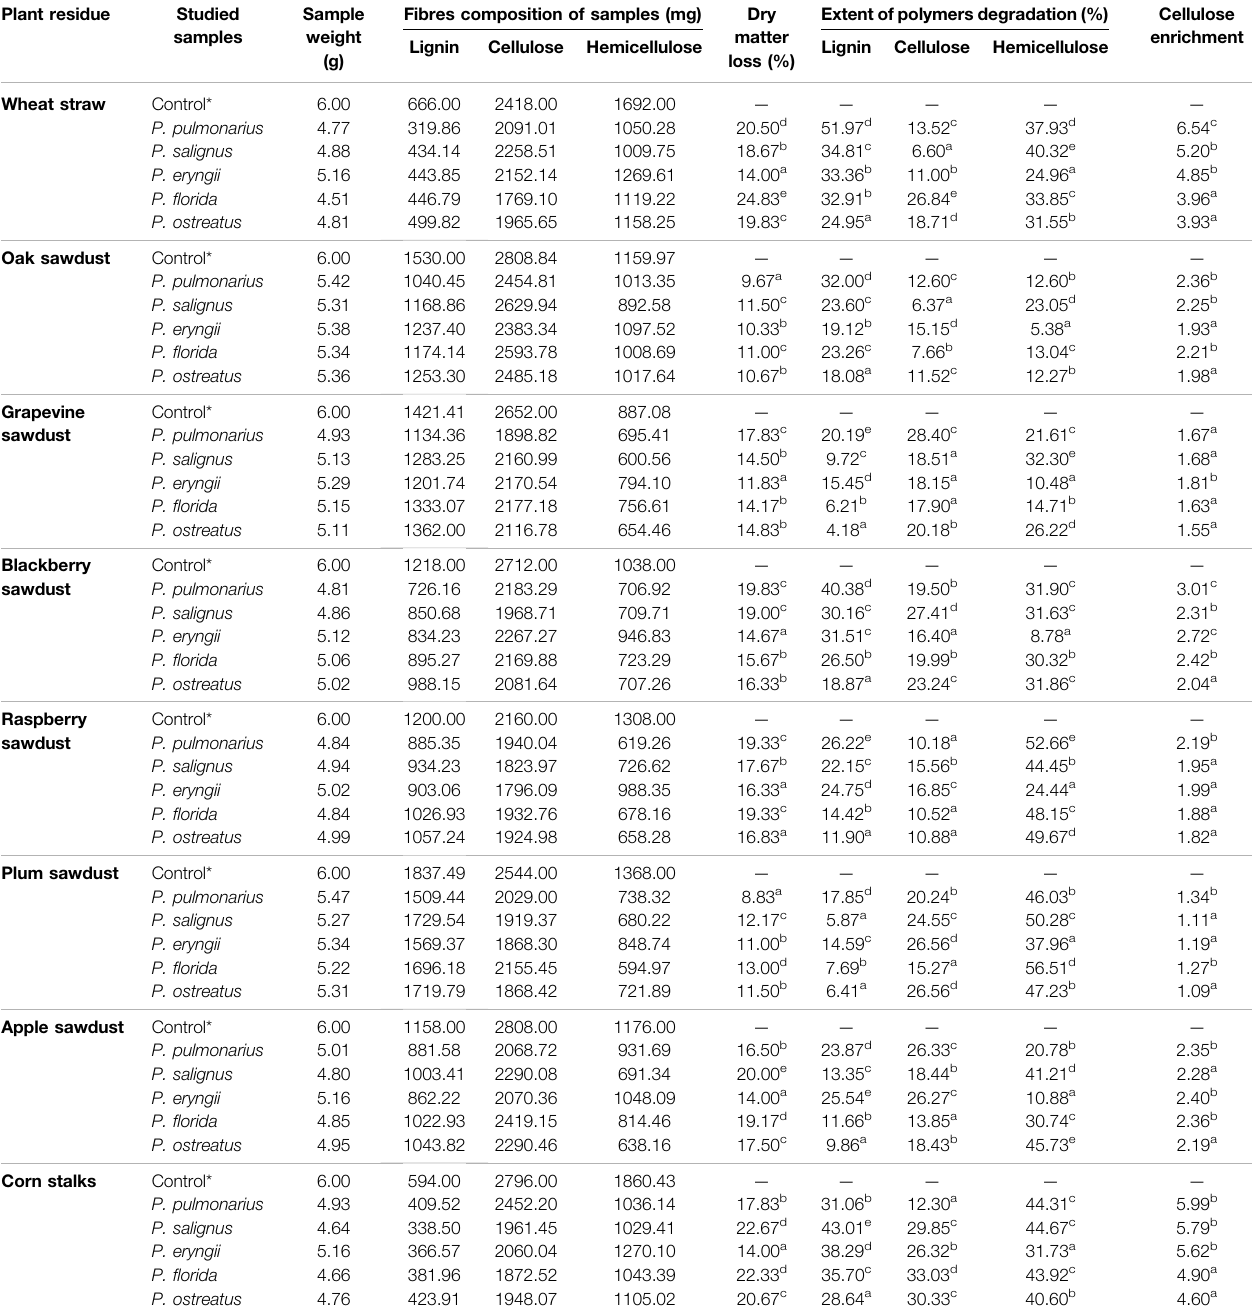
TABLE 2 | Extent of depolymerization of plant residues by Pleurotus